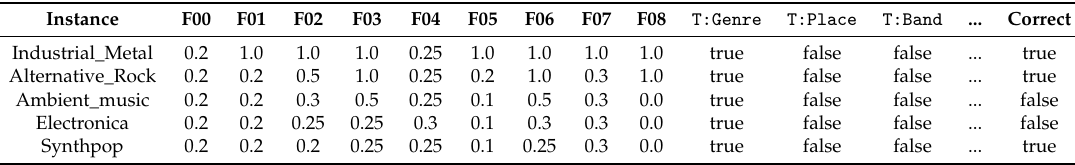
Table 3. Example Feature